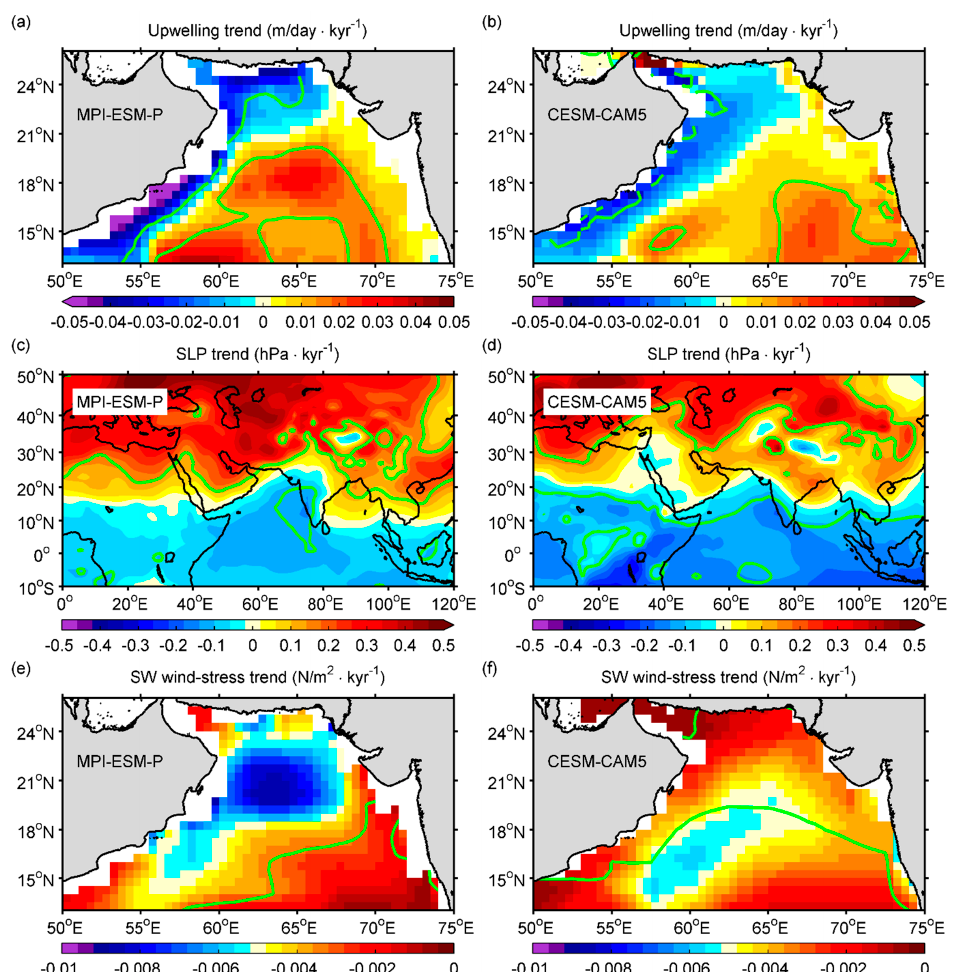
Figure 6. Long-term trends of JJA upwelling velocity modeled by ( a ) MPI-ESM-P and ( b ) CESM-CAM5. Long-term trends of JJA SLP modeled by ( c ) MPI-ESM-P and ( d ) CESM-CAM5. Long-term trends of JJA SW wind-stress in the Arabian Sea modeled by ( e ) MPI-ESM-P and ( f ) CESM-CAM5. The regions surrounded by the green contour lines present significant trends that are at a higher level than 90% ( p -value < 0.1). These trends are likely induced by the external forcing used to drive the models.